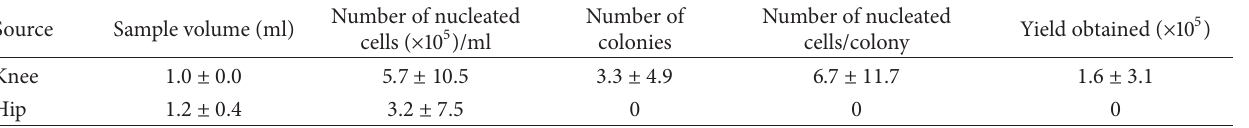
Table 3: Data on the cell samples derived from synovial fluid of 8 donors. Values are shown as mean ± standard deviation.